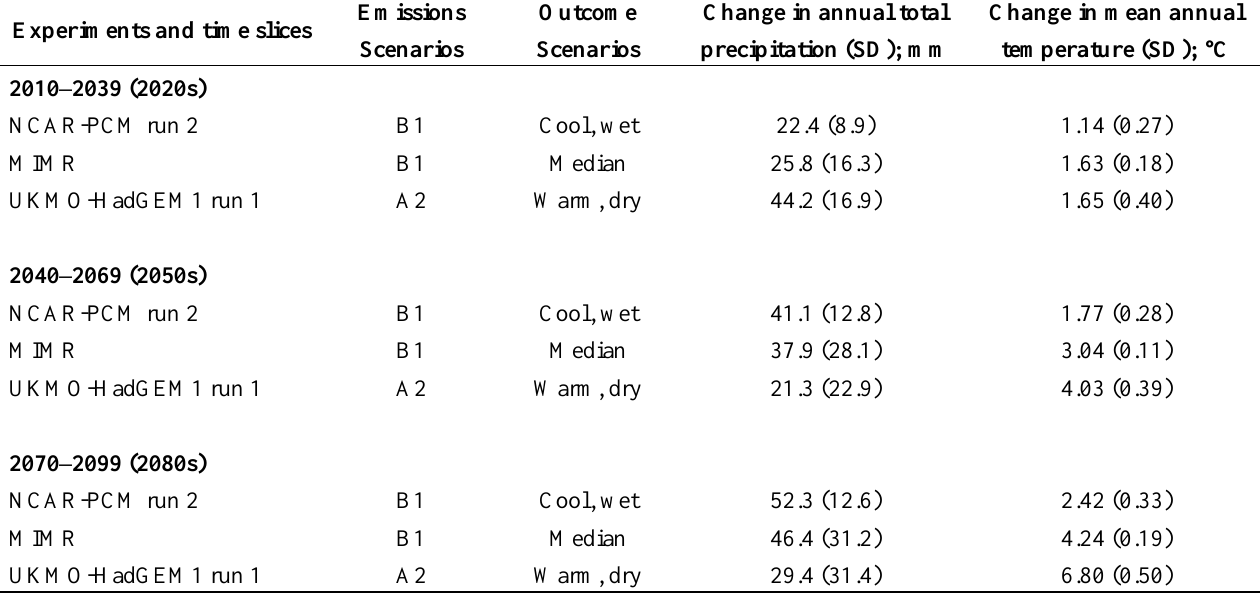
Table 3. Outcome scenarios selected to represent the range of effects of future climate change in the Canadian prairie provinces and their associated changes in mean annual temperature and precipitation in 3 time slices, compared to baseline climate conditions